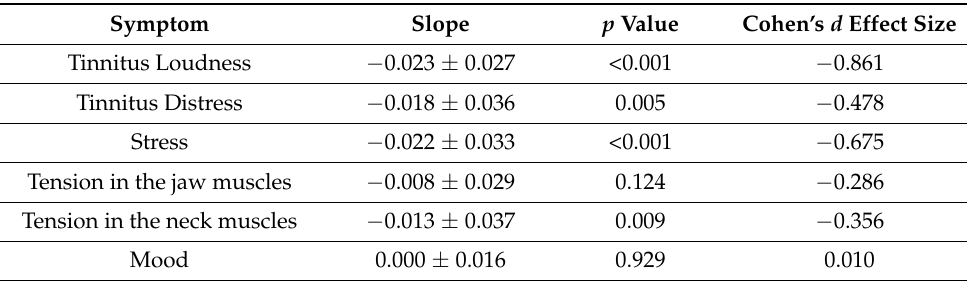
Table 3. Results of the linear trend analyses.